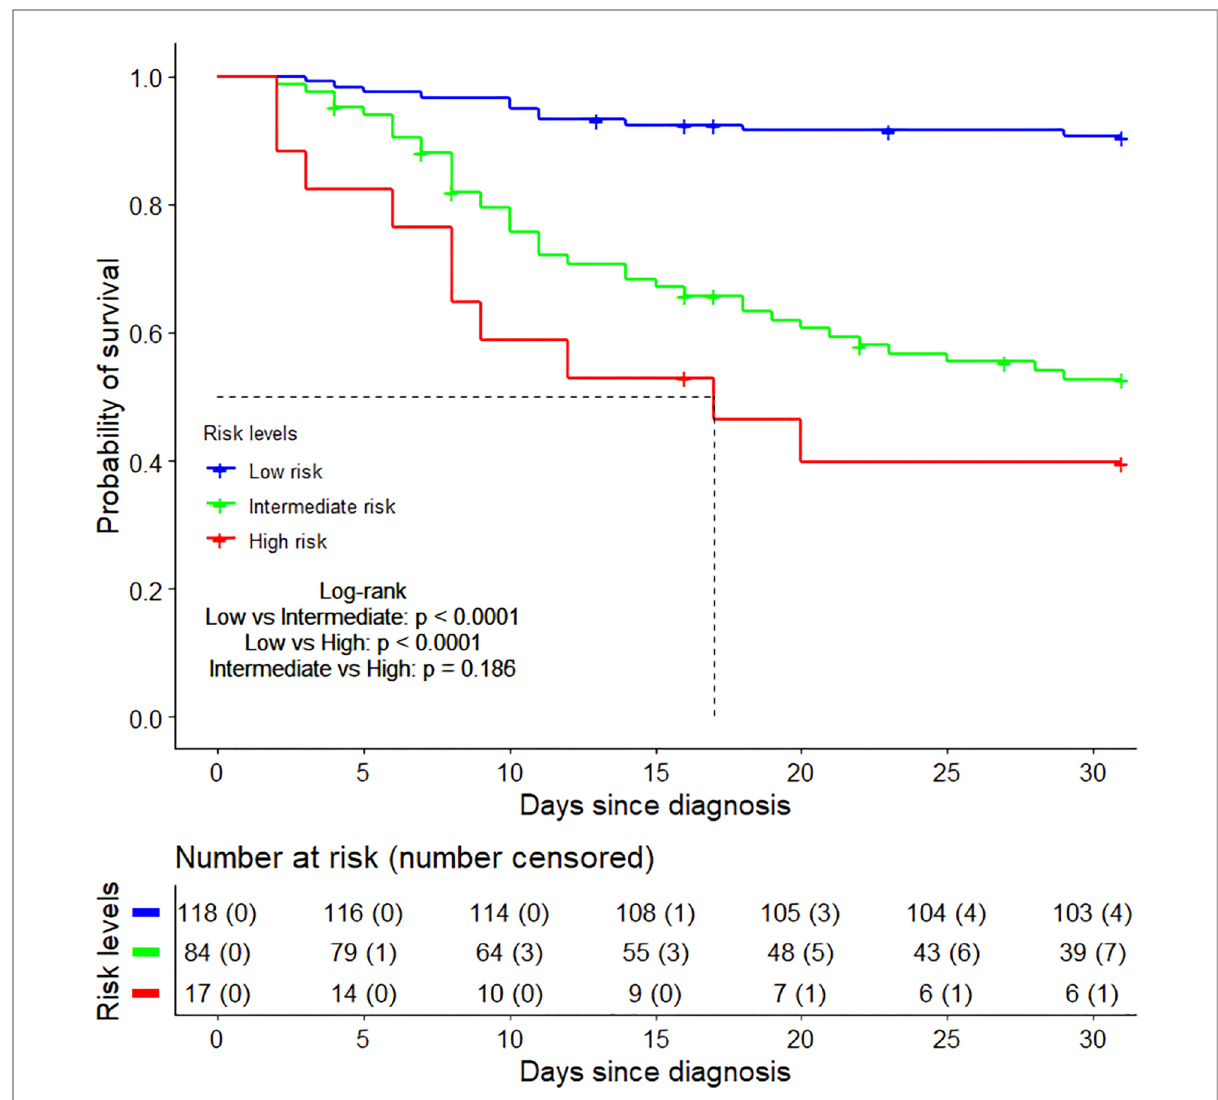
FIGURE 10 The Kaplan – Meier survival curves of three risk groups within 30 days after diagnosis. Low risk group (no risk factors present), Intermediate risk group (one risk factor was present), High risk group (two risk factors were